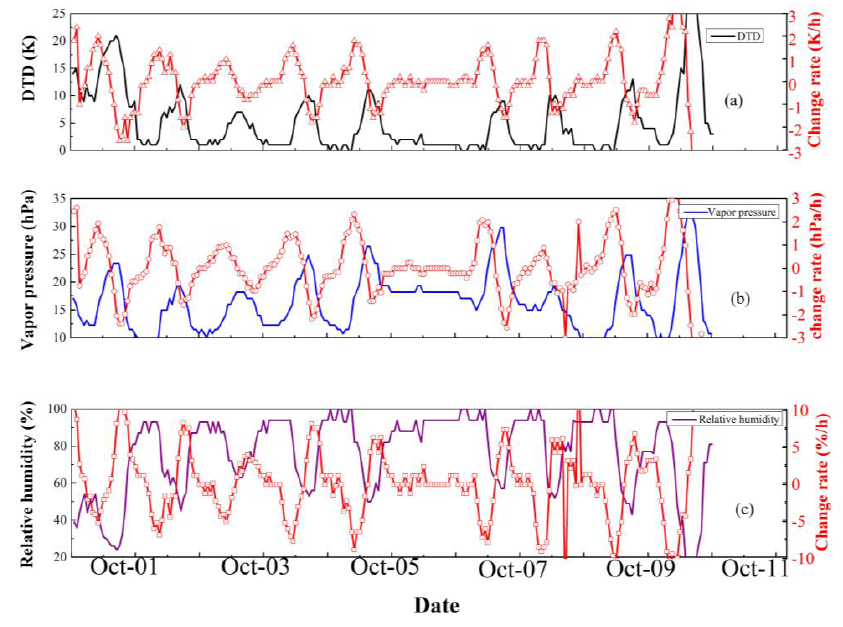
Figure 14 . Time series of meteorological parameters and the corresponding change rates during rainfall case. ( a ) dew-point temperature difference; ( b ) vapor pressure; ( c ) relative humidity.